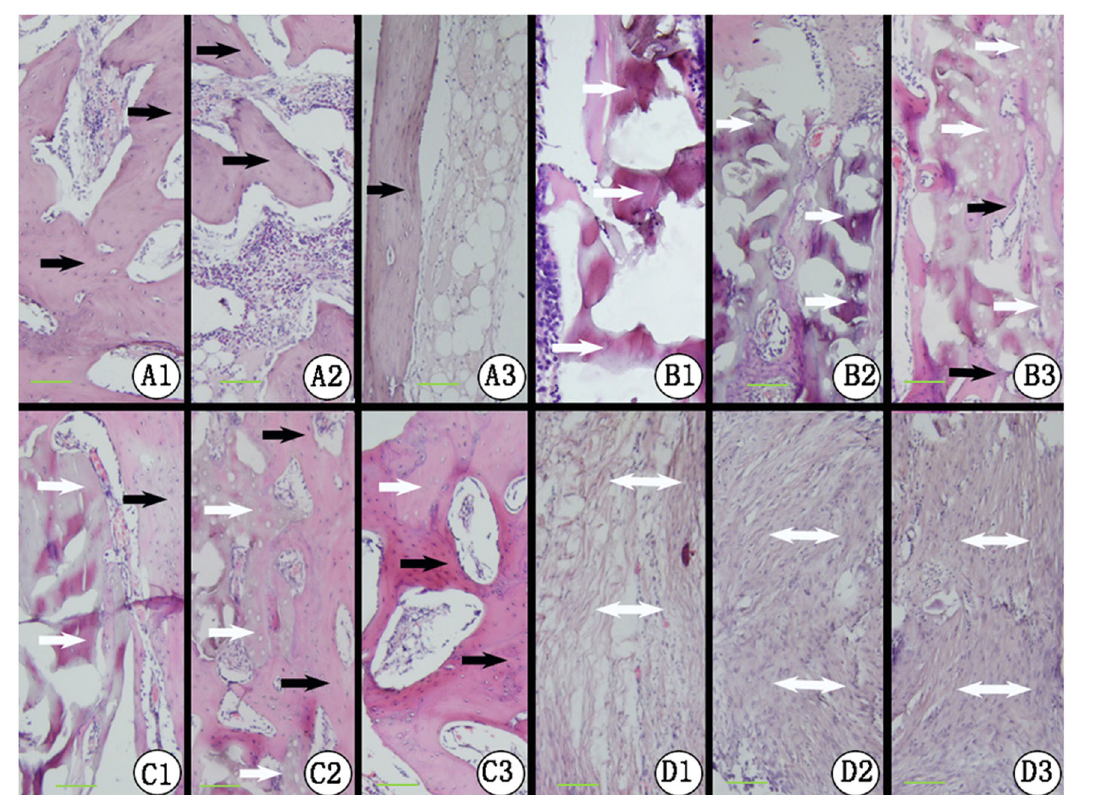
Fig. 7 Histological inspection of HE staining in Group A at 4 weeks ( A1 ), 8 weeks ( A2 ) and 12 weeks ( A3 ); in Group B at 4 weeks ( B1 ), 8 weeks ( B2 ), and 12 weeks ( B3 ); in Group C at 4 weeks ( C1 ), 8 weeks ( C2 ) and 12 weeks ( C3 ); and in Group D at 4 weeks ( D1 ),